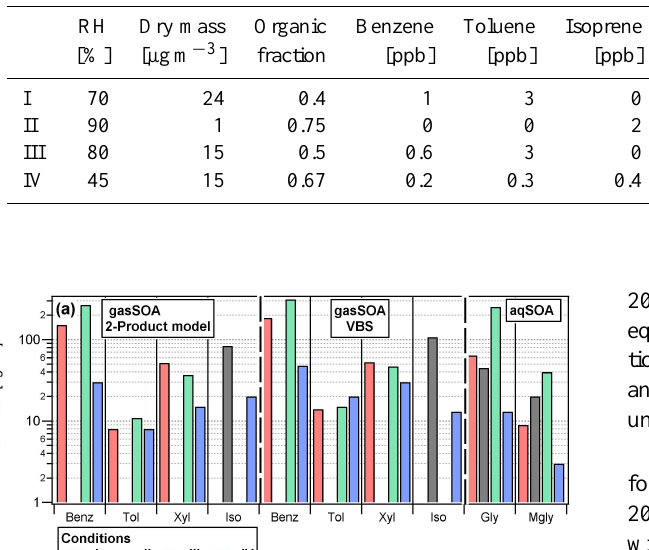
Table 3. Initial conditions for box model studies to evaluate gasSOA and aqSOA mass formation, Eq. (7). Model results are presented in Fig. 7.